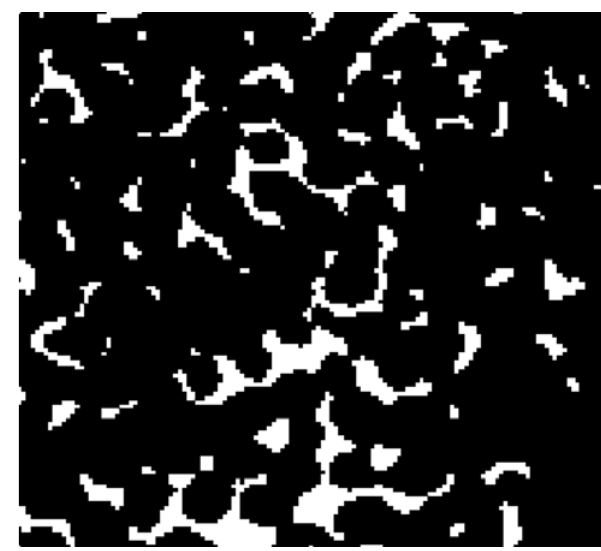
Figure 12. Binary image pattern of the 60 ppi sample.